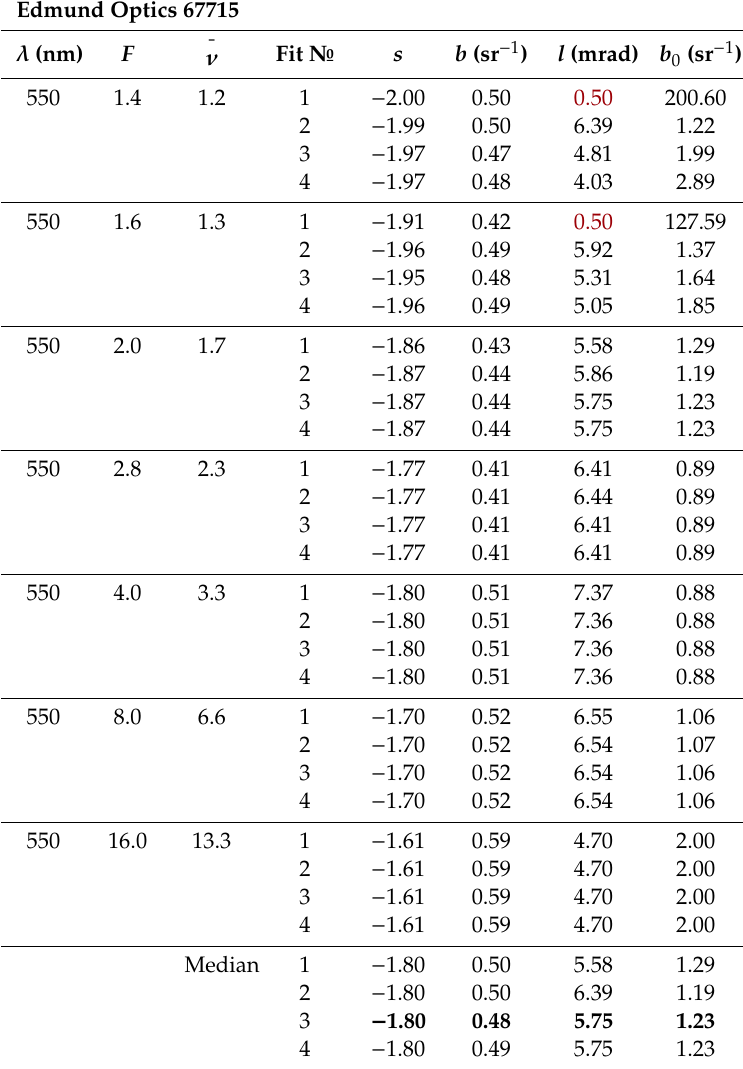
Table A2. Fit results for the lens Edmund Optics